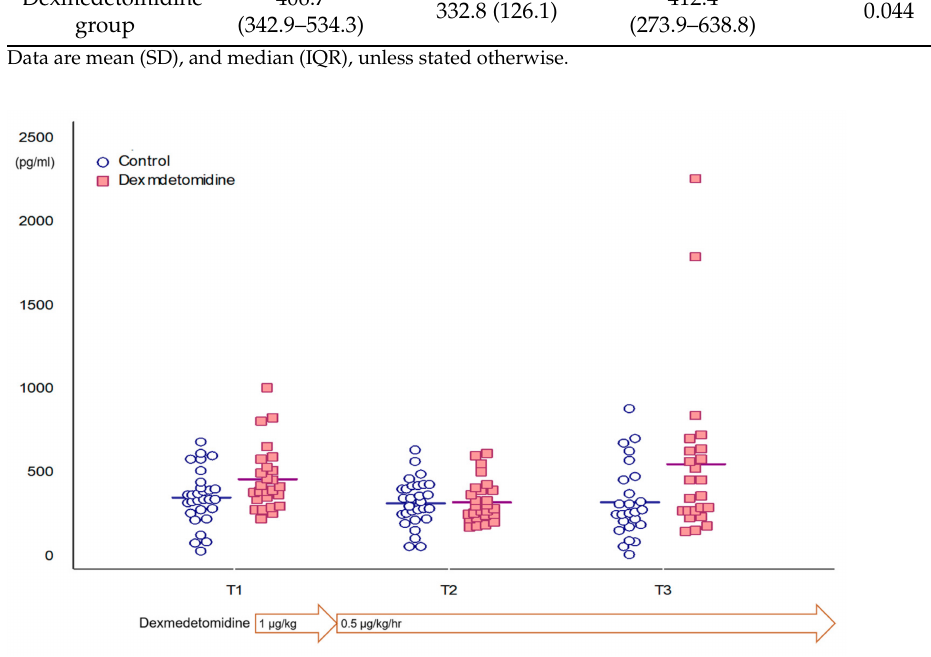
Figure 2. Plasma glial fibrillary acidic protein concentration differences during surgery between the